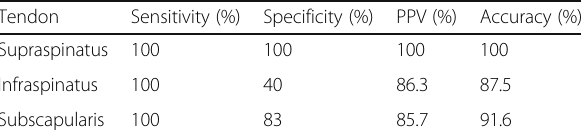
Table 6 Sensitivity, specificity, positive predictive value and accuracy of combined CTA and subacromial bursography in the detection of RCTs Tendon